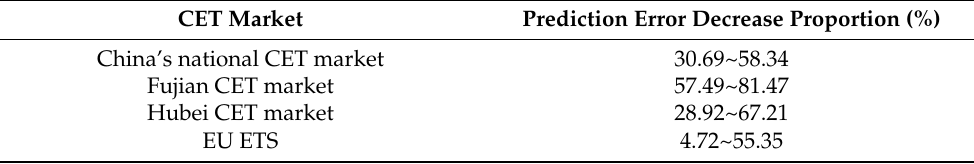
Table 5. The decrease in prediction error of XGBoost(W-b) compared to other algorithms.